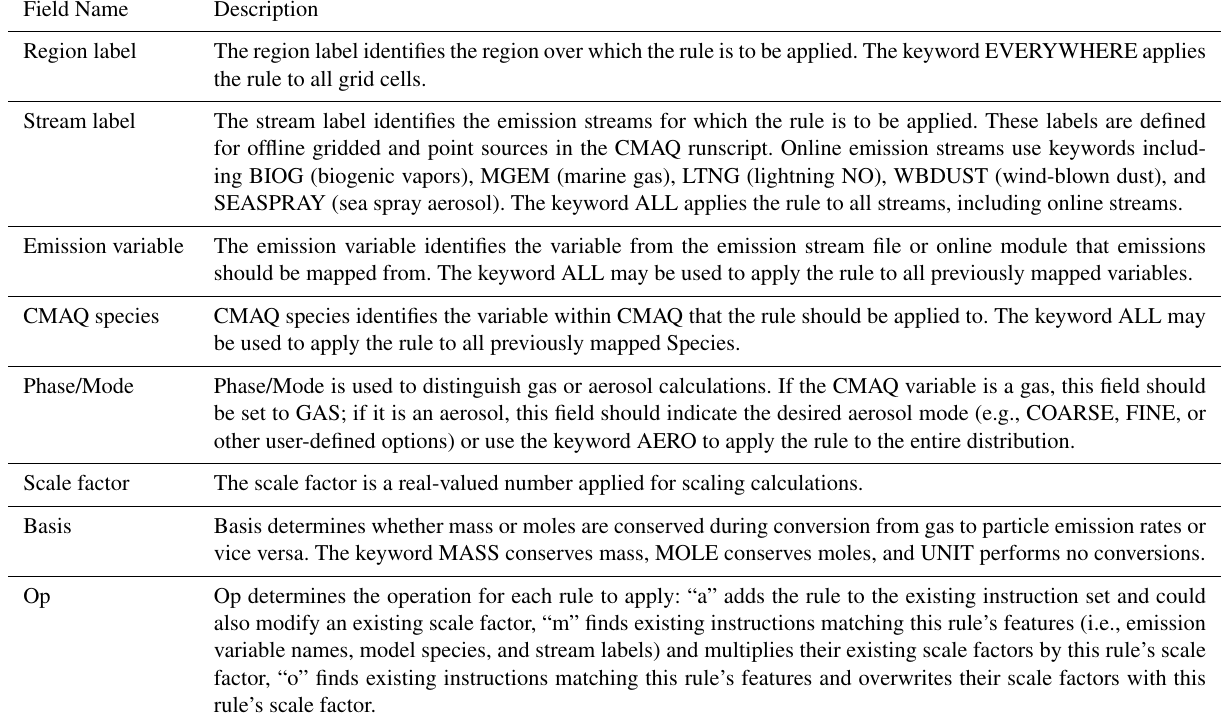
Table 1. Fields required for articulating emission scaling rules in